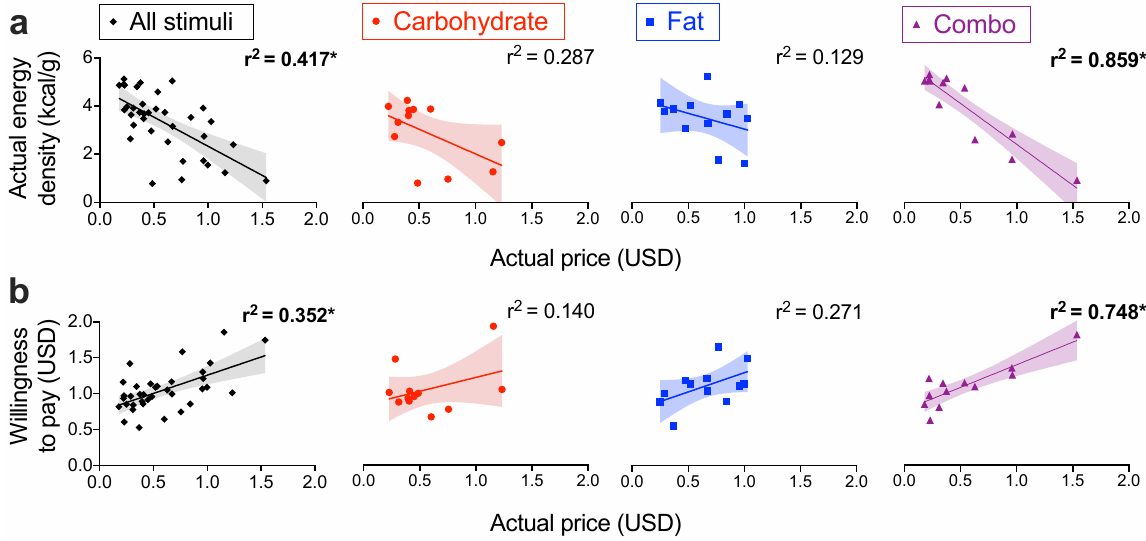
Figure 4. Actual price is associated with energy density and WTP across all stimuli and in combo foods. Fitted scatter plots depict the relationships of actual food price with ( a ) actual energy density and ( b ) WTP. Resulting r 2 values are shown for each regression performed on all food items (averaged across all participants) or broken down by the carbohydrate, fat, and combo categories. Each data point depicts a single item (36 total stimuli or 12 foods per macronutrient category) and shading indicates 95% CI. * p < 0.0063 after Bonferroni correction for the eight